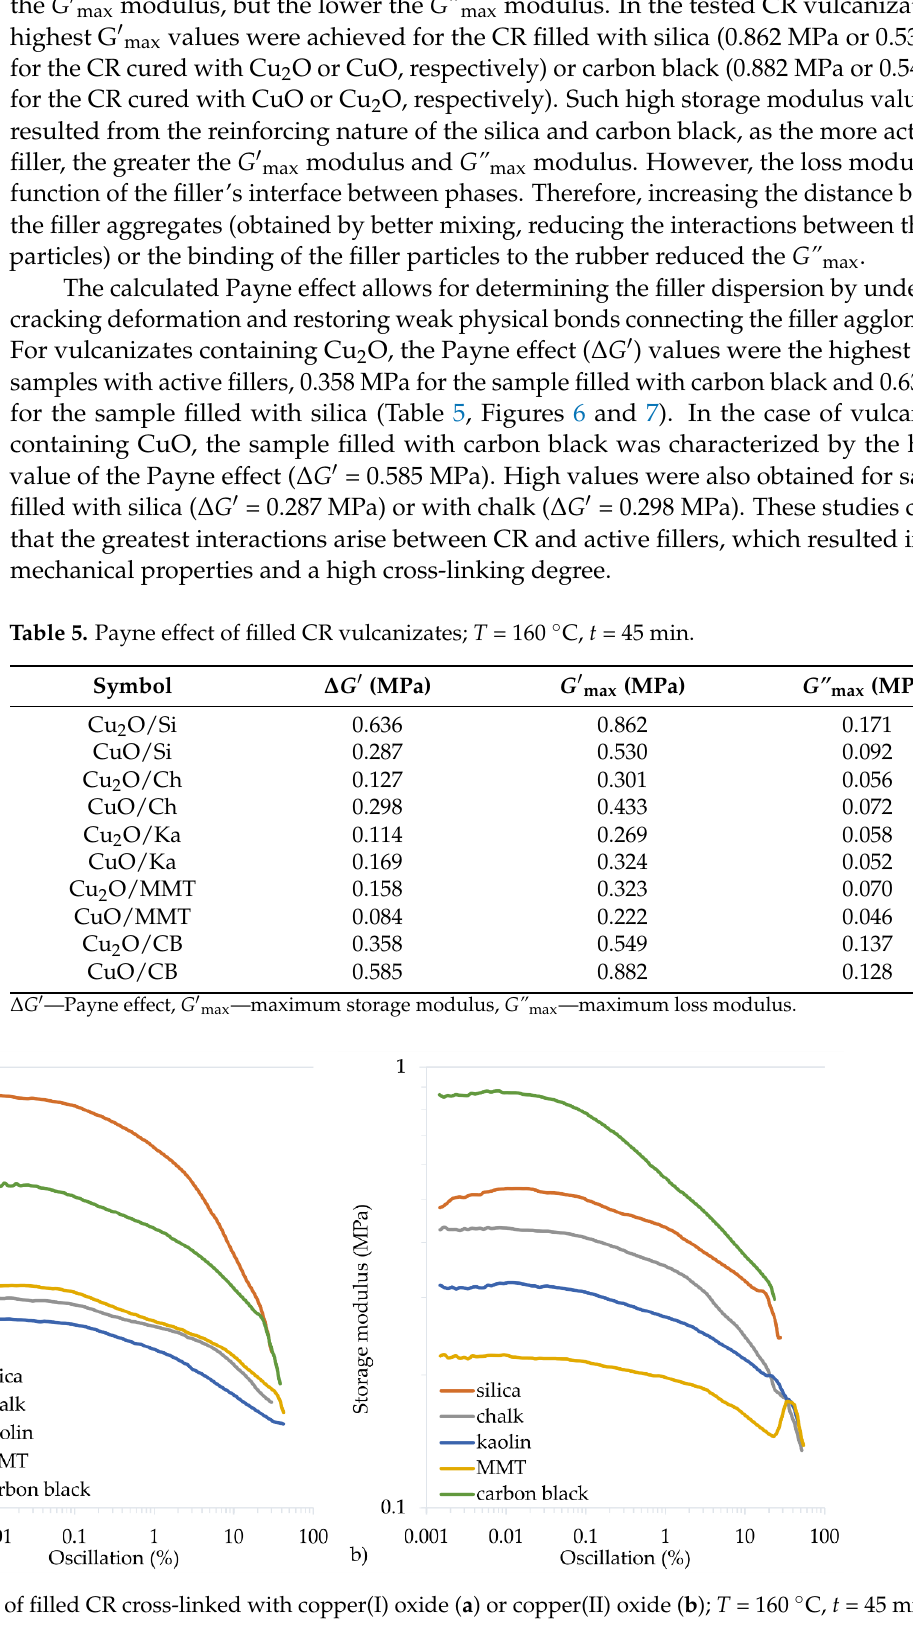
Figure 7. Loss modulus of filled CR cross-linked with copper(I) oxide ( a ) or copper(II) oxide ( b ); T = 160 °C, t = 45 min. The differences between the behavior of carbon black and silica in the CR matrix dur- ing the dynamic measurements can be explained by their different energy surface prop- erties. In the case of carbon black, the interactions with the rubber are usually stronger than those in the case of silica, because of the higher dispersion component of the carbon black. On the other hand, silica particles show a stronger tendency to interact in the CR matrix, as well as a greater tendency to agglomerate, which results from the high value of the specific interaction parameter. Thus, the slope of the stress – strain curve in dynamic measurements is related to the type and strength of the filler – rubber and filler – filler inter- actions. The analysis of the mechanical and dynamical property measurements of the filled chloroprene rubber vulcanizates shows that the active fillers, i.e., silica and carbon black, create the most developed interactions with the elastomer. Such developed elastomer- filler interactions result in an increase in tensile strength, a reduction in elongation at the break, and an increase in the Payne effect. However, less active fillers also improve the